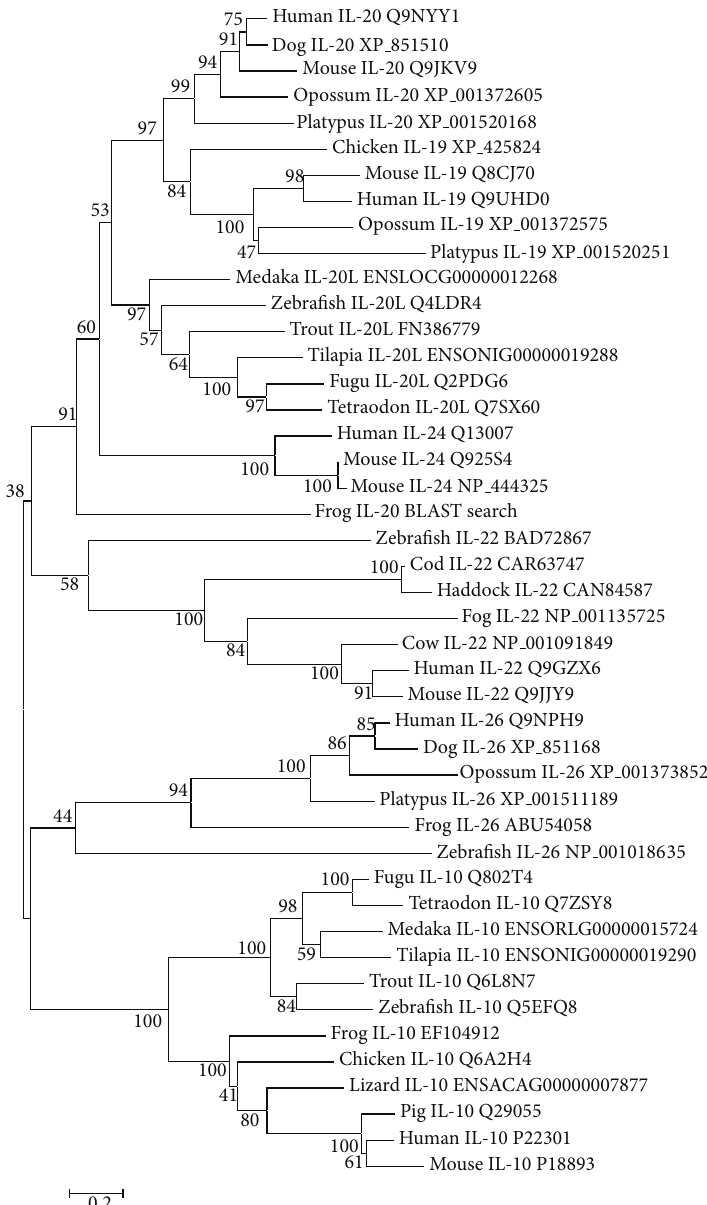
Figure 6: Phylogenetic tree analysis of IL-10 family members from frog and other species. The tree was constructed by the “neighbor-joining” method using MEGA 6.0 software. Node values represent the percent of bootstrap confidence derived from 1,000 replicates. The accession number for each sequence followed the common species